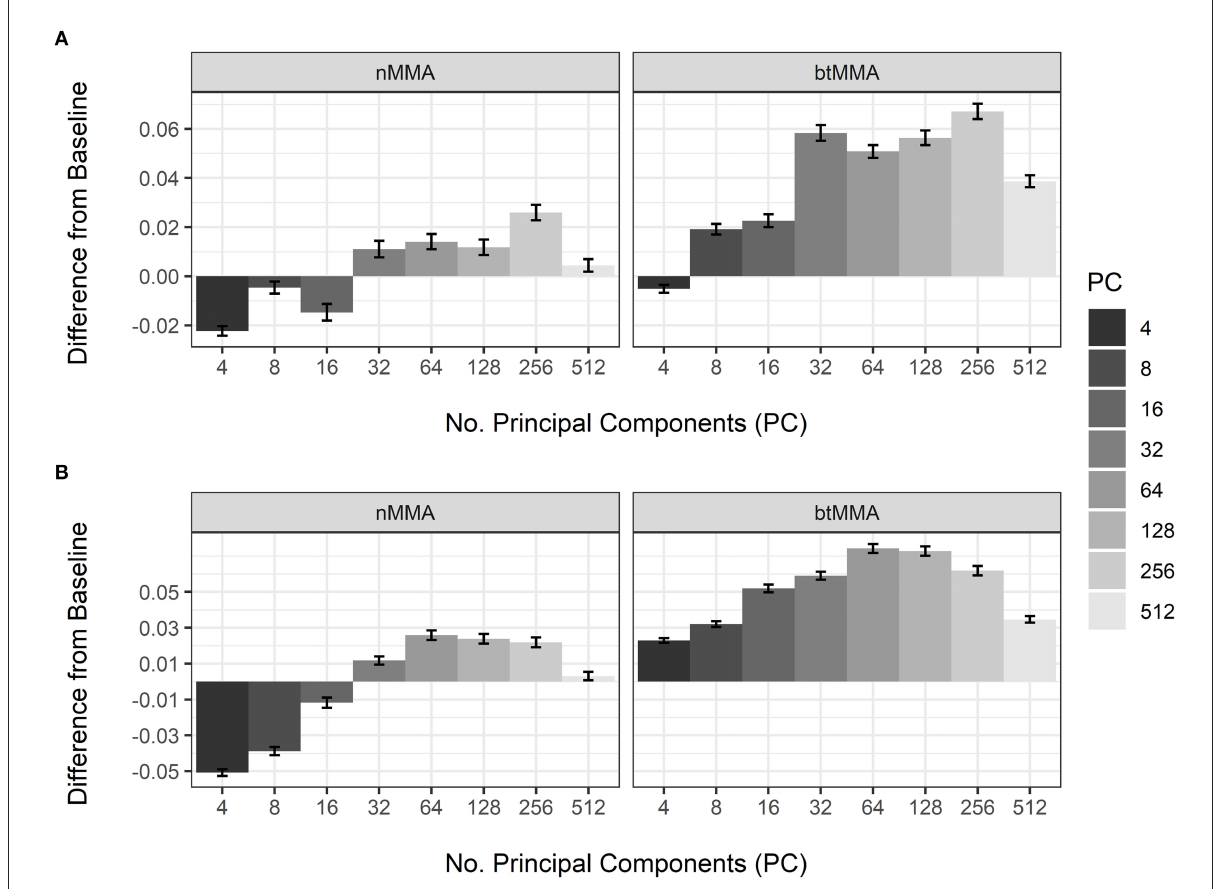
FIGURE4 Effect of number of principal components (PC) on the variation of nMMA (naïve major-mean accuracy) and btMMA (best-threshold major-mean accuracy) of the LSTM (A) and the CNN (B) networks. The baseline is not applying principal component analyses to the extracted